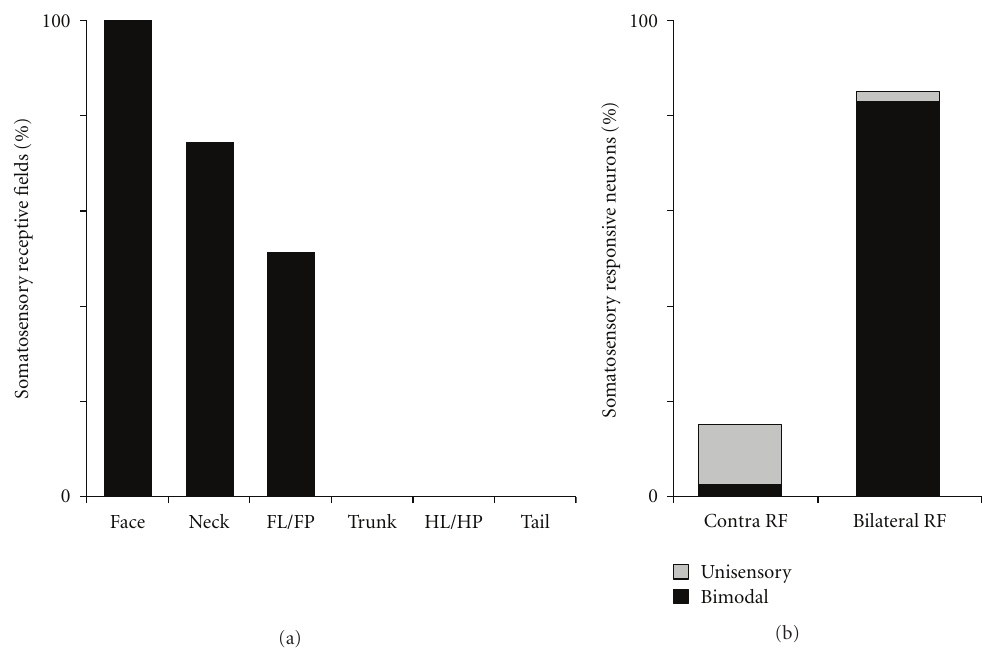
Figure 7: Somatosensory receptive field properties of neurons in core auditory cortex of early hearing-impaired ferrets. Part (a) shows that all somatosensory receptive fields included representation of the face and that these often extended into the neck or forelimb/forepaw (FL/FP) regions. Conversely, no somatosensory receptive fields were observed representing the posterior portion of the body (trunk, hindlimb/hindpaw (HL/HP), tail). Part (b) illustrates that the overwhelming majority of somatosensory receptive fields were bilateral (included ipsi- and contralateral body surface) of which 97% occurred in bimodal auditory-somatosensory neurons (black region of bar). In contrast, comparatively few neurons exhibited exclusively contralateral somatosensory receptive fields, most of which (86%; grey region of bar) occurred in unisensory somatosensory